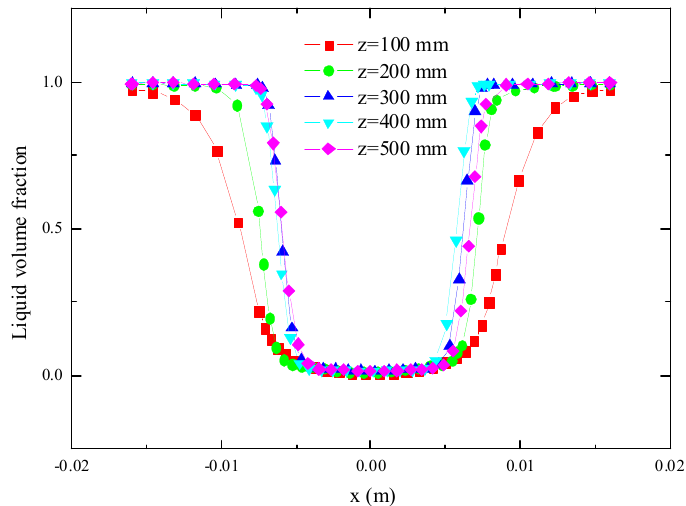
Figure 10. Radial distribution of liquid volume fraction at different positions in the inner cylinder.